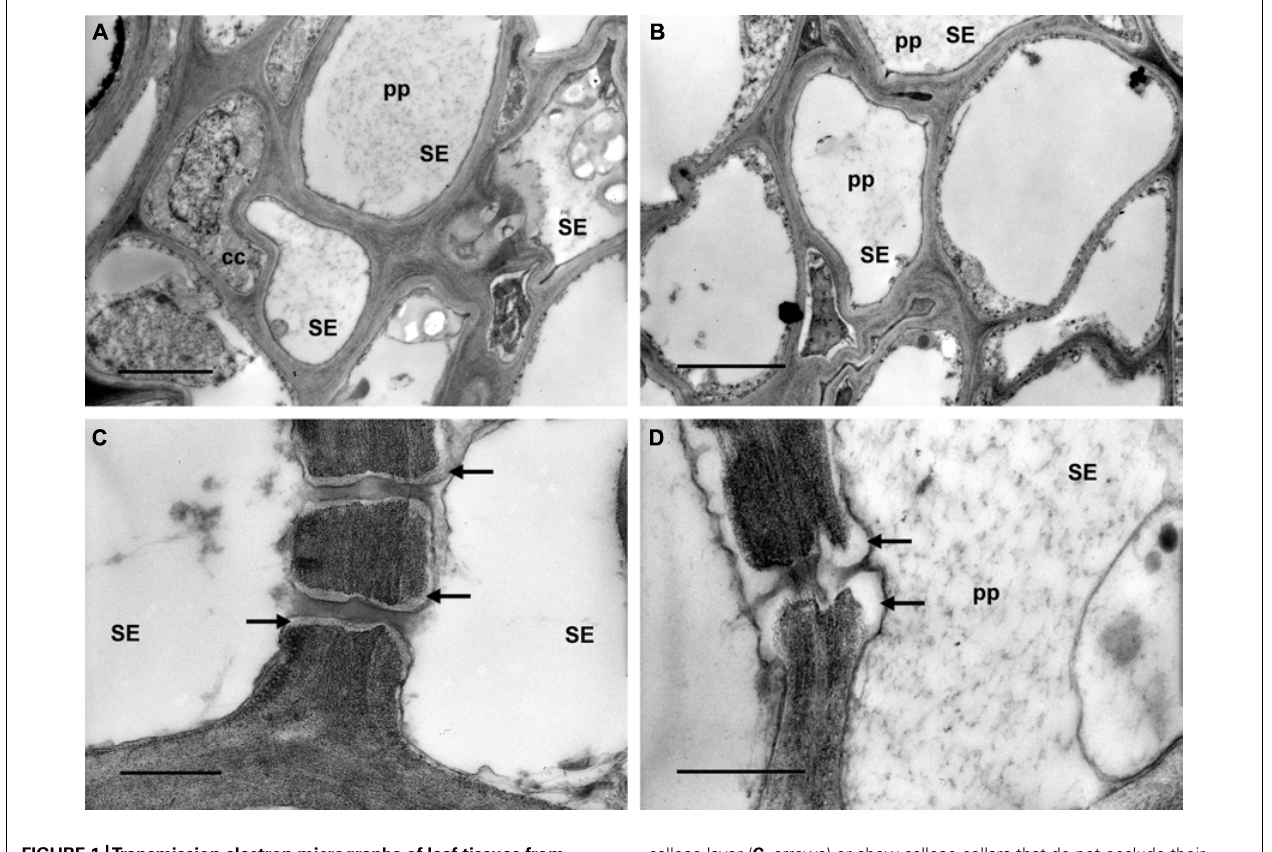
callose layer ( C , arrows) or show callose collars that do not occlude their lumen ( D , arrows). In (A) and (B) bars correspond to 2 μ m; in (C) and (D) bars correspond to 0.5 μ